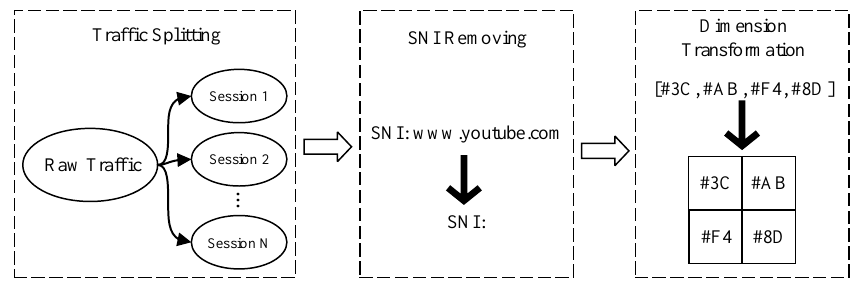
Figure 2. Flow of data preprocessing.